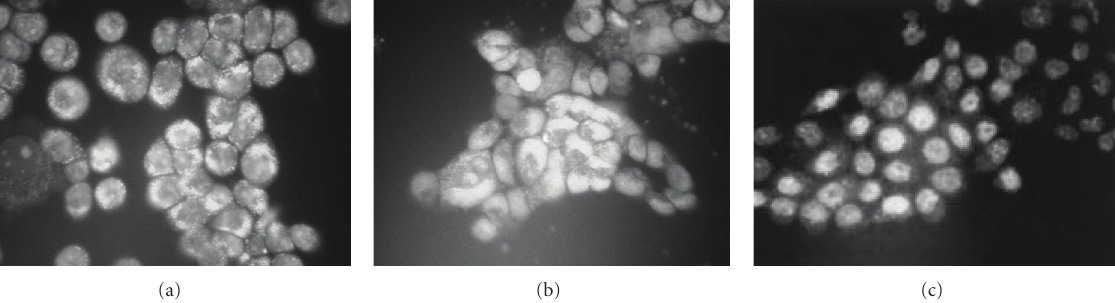
Figure 15: NCP/HK1 cells cultured on culture disk were incubated with 200 μ M of berberine for 2 to 46 hours. (a) Cells treated for 2 hours; (b) cells treated for 21 hours; (c) cells treated for 46 hours. Fluorescence indicated the presence of berberine. Reprinted from Szeto et al. [115] with permission from the Turkish Journal Medical Science with permission from the publishers.